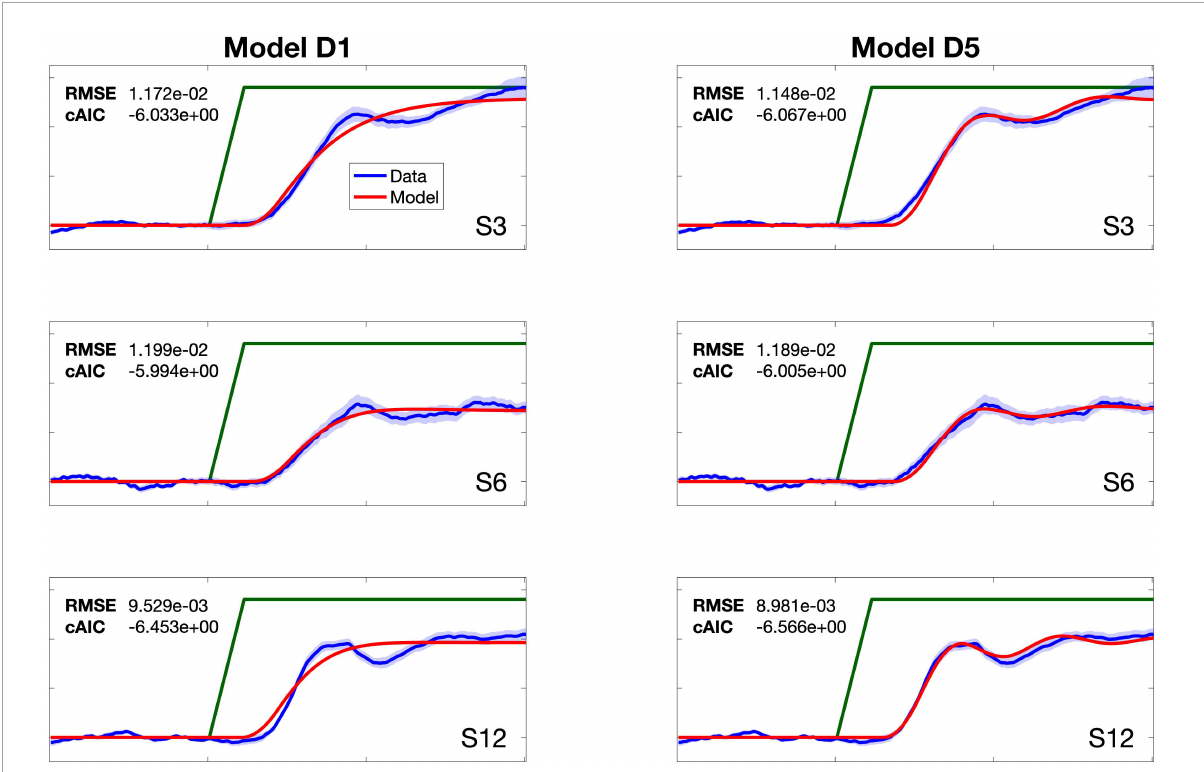
FIGURE4 Comparison of the fits for models D1 and D5 for three subjects (S3, S6, S12) from Study 1 who showed multi-component response profiles. Subjects’ mean data traces and standard error of the mean are shown with blue line and shading, respectively. Model fits shown with red